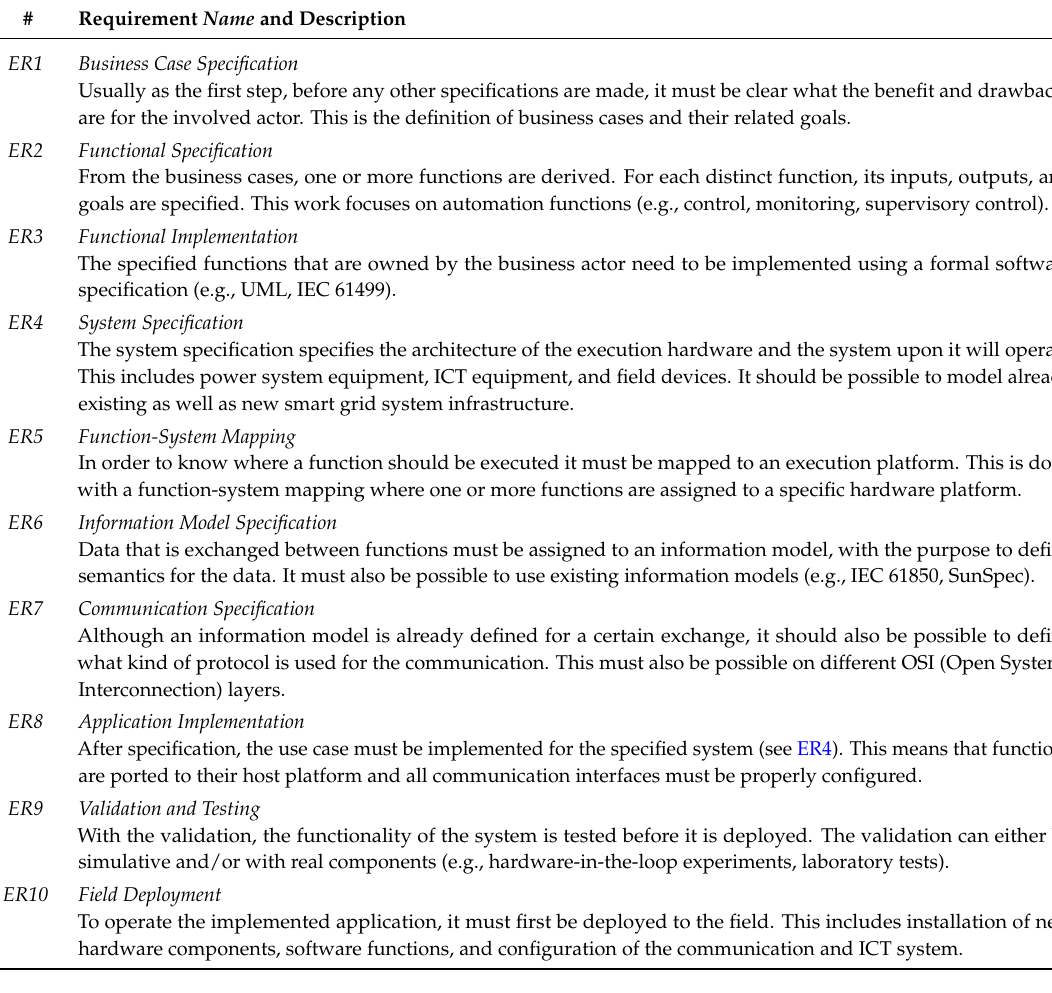
Table 2. Engineering requirements for the rapid engineering